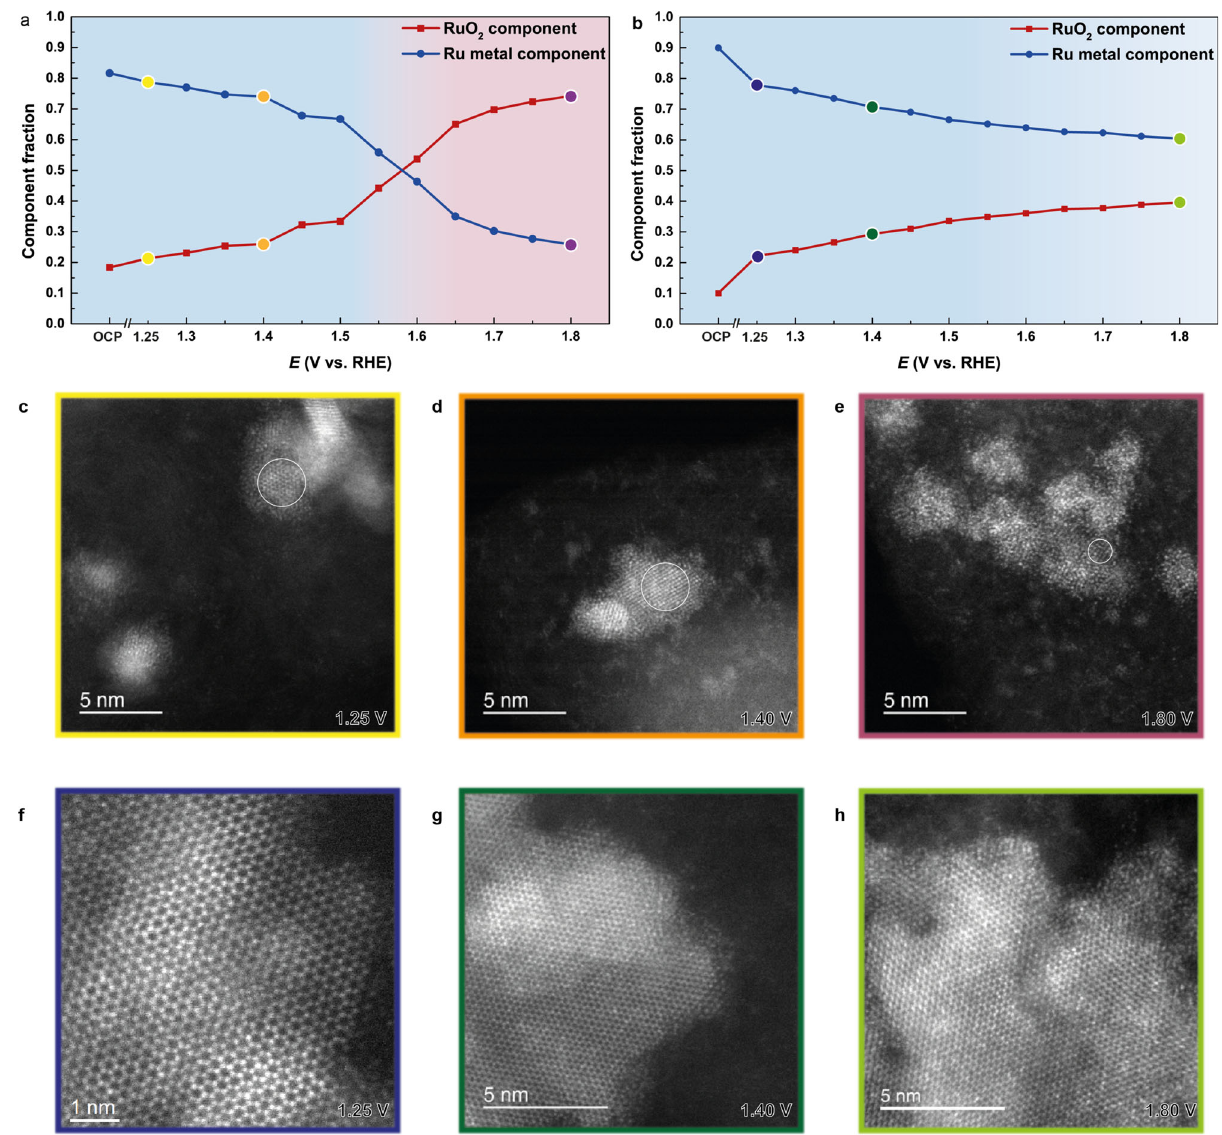
Fig. 3 Potential-dependent local and surface structural changes. Linear composition fi tting (LCF) results using two components, Ru metal and RuO 2 in the X-ray absorption near-edge structure (XANES) spectra of a RuIr-NS and b RuIr-NC collected by operando tests. The coloured circles coincide with the colour outer boxes in ( c ‒ h ). The background colours are used for guiding eyes. HAADF-STEM images showing the morphology changes in c – e RuIr-NS and f – h RuIr-NC under 1.25 V ( c , f ), 1.40 V ( d , g ) and 1.80 V ( e , h ). The circles in ( a ‒ c ) show the crystalline part of the RuIr-NS